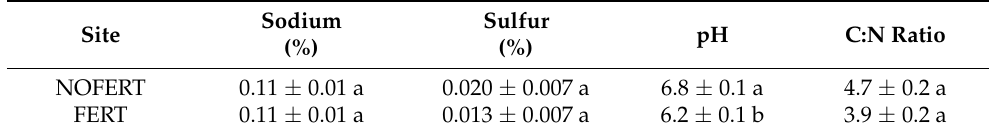
Table 5. More soil properties (mean ± SE) during the 2018 NOFERT and FERT treatments. Treatments with different letters are significantly different using an ANOVA test, α = 0.05.